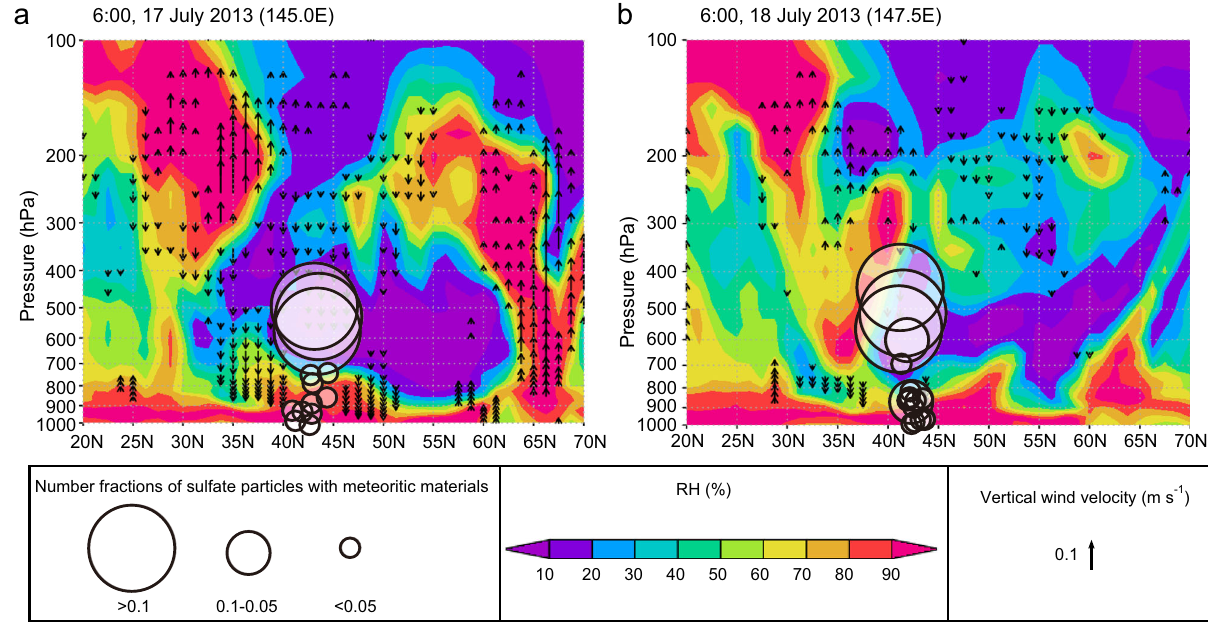
Fig. 6 Vertical distribution of number fractions of sulfate particles with meteoritic materials and relative humidity. The number fractions of sulfate particles with meteoritic materials (circles), relative humidity (RH; color bar is shown at the bottom), and vertical wind velocity (m s − 1 ; vectors with scaling near the lower right corner) are shown as a function of pressure and latitude for fl ights on a 17 July (145°E) and b 18 July (147.5°E). Dry air represented in purple, and downward motion between 400 and 700 hPa indicates tropopause-folding events. Plots of all fl ights are shown in the Supplementary Information (Supplementary Fig. 5). The meteorological data were obtained from the Japanese 55-year reanalysis data. Vertical wind velocities (m s − 1 ) were calculated from omega-velocities (Pa s − 1 ) in the data. Only wind vectors with magnitudes greater than 0.015m s − 1 were